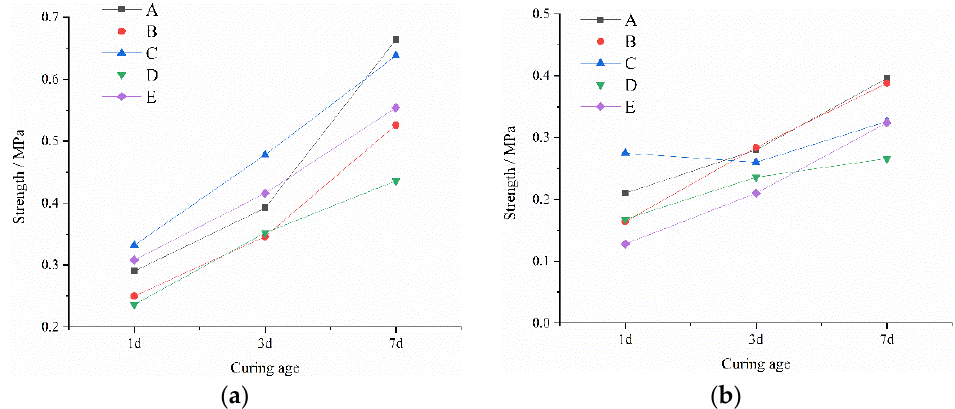
Figure 5. Two stress peaks of specimens: ( a ) maximum compressive strength; ( b ) maximum re- bound stress. rebound